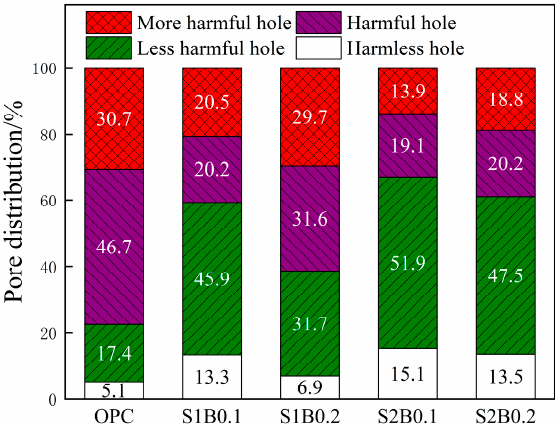
Figure 7. Pore distribution of fiber concrete under an acid rain environment.